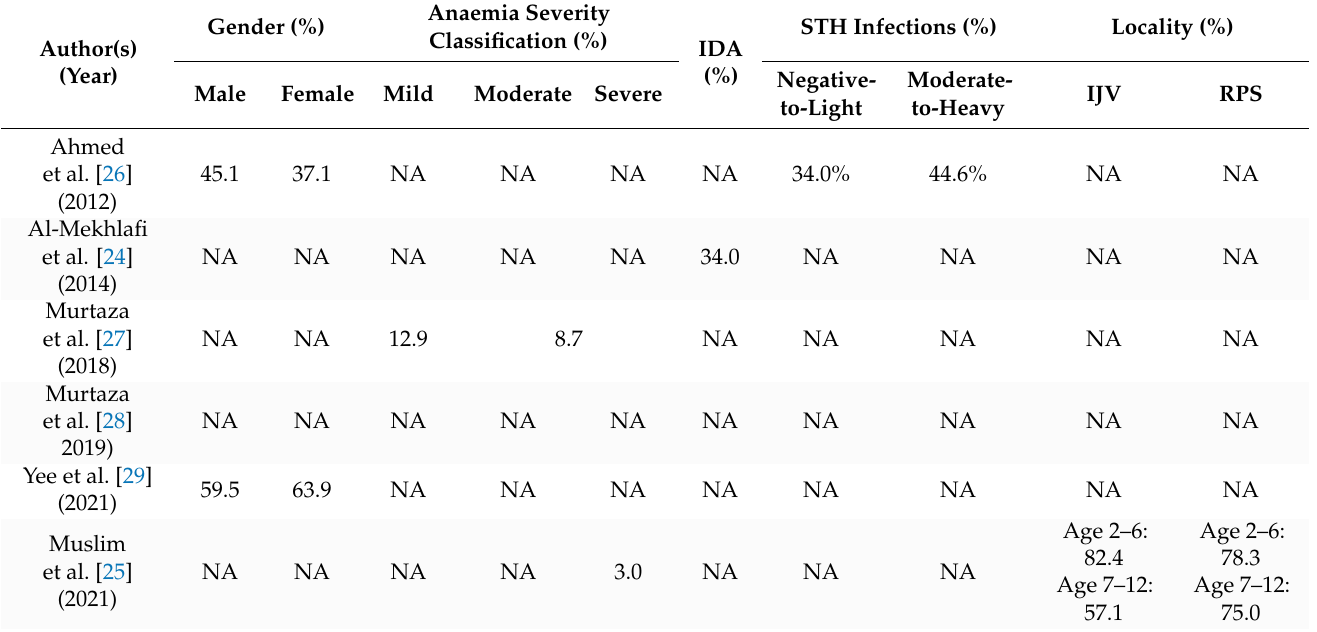
Table 2. Anaemia-specific prevalence among OA children in